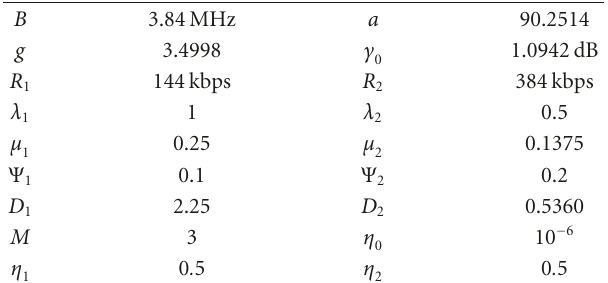
] and E [ φ ] in (20) and (21). des int